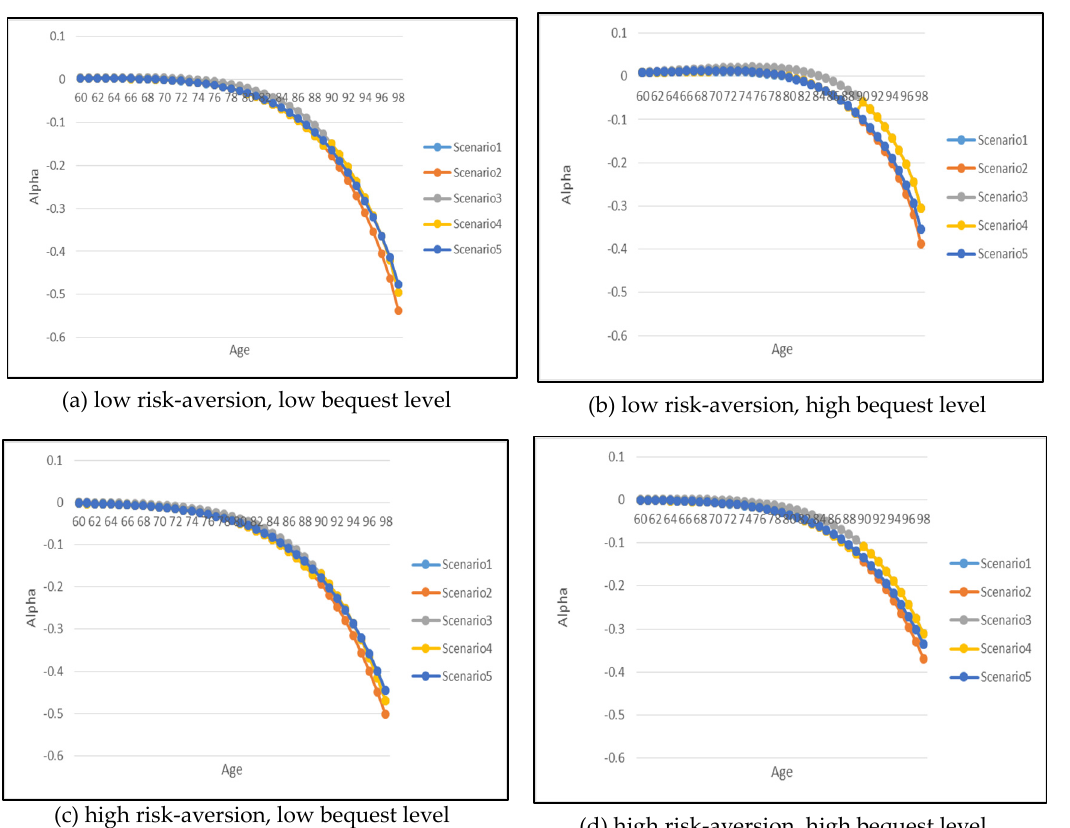
Figure 10. Optimal Annuity/Insurance Purchase for Males (Health-Dependent Utility).